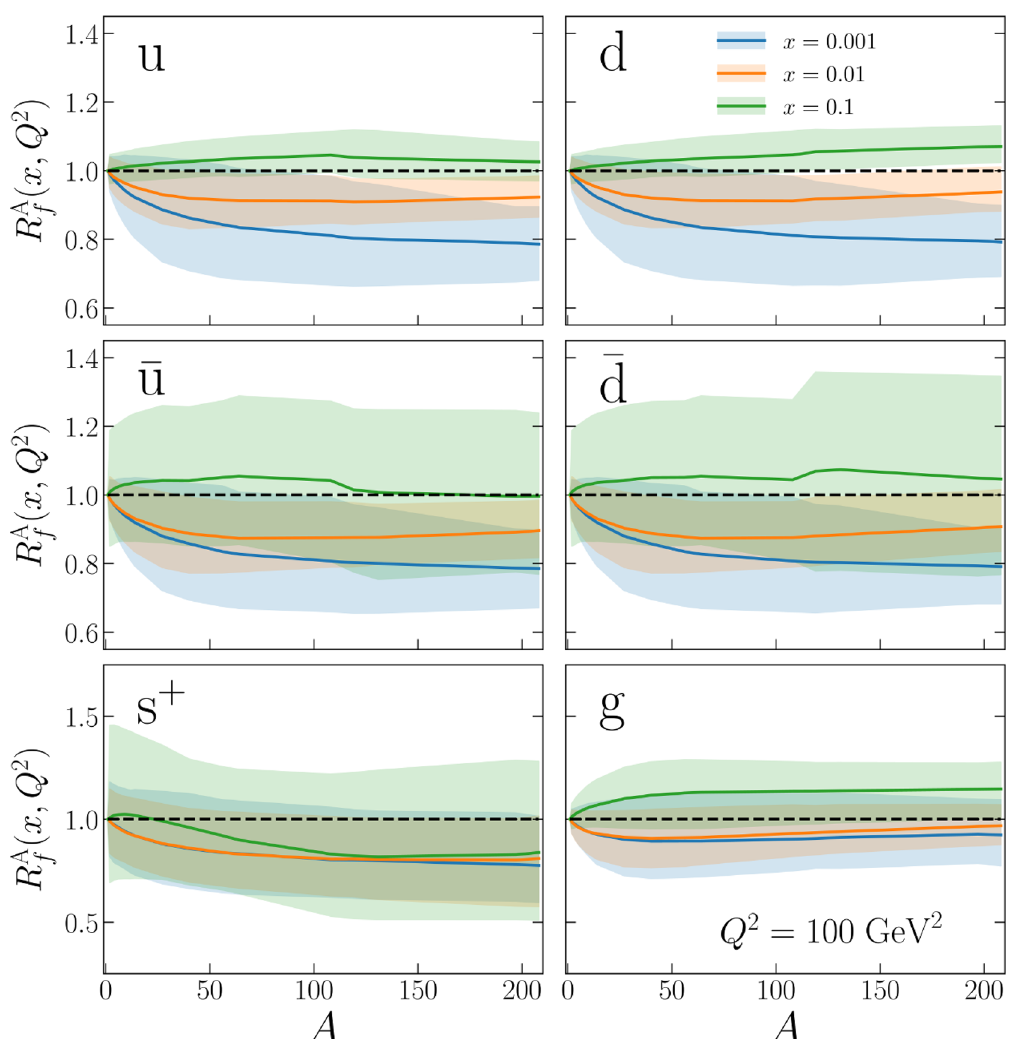
Figure 12 . Comparison of the nuclear PDF ratios, eq. (4.4) as a function of atomic mass A for three di(cid:11)erent x values, x = 0 : 001, x = 0 : 01, and x = 0 : 1, at Q = 10 GeV. From top to bottom we show the up and down quarks, the corresponding antiquarks, the total strangeness, and the gluon. The bands indicate the 90% con(cid:12)dence level intervals and take into account the correlations with the proton baseline used for the